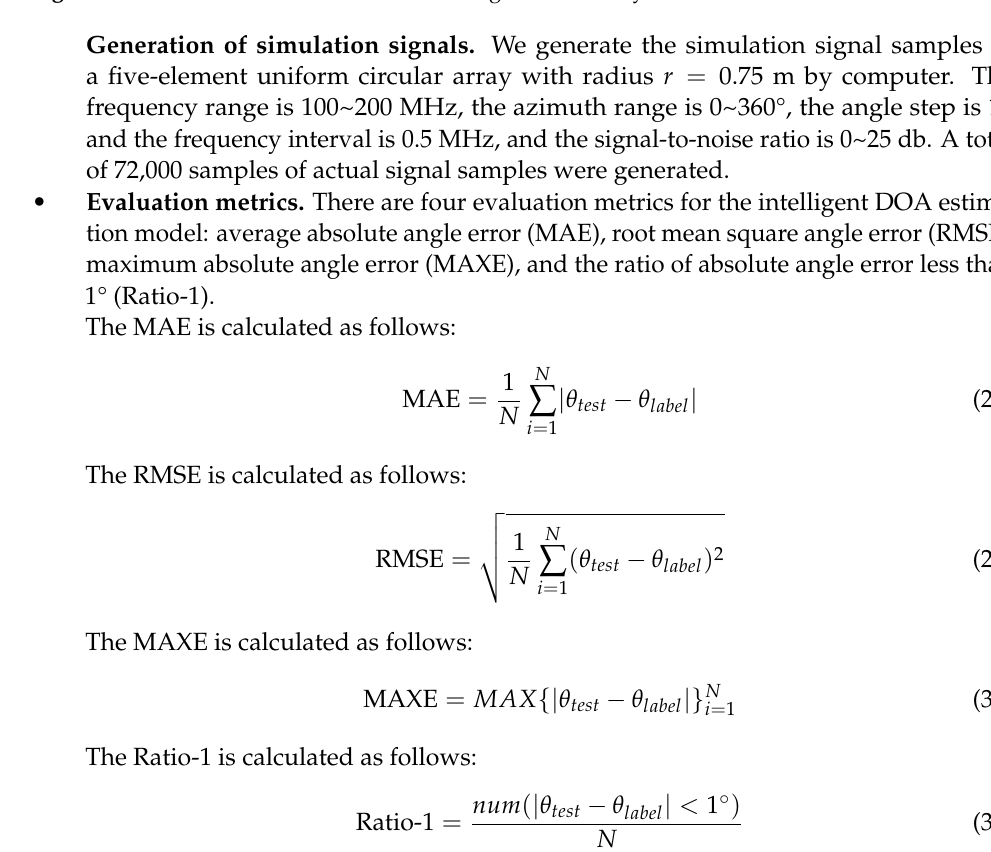
Figure 8. The ultrashort wave direction-finding antenna